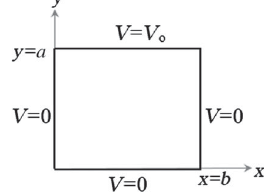
FIG. 3. The multiple-response CUE question related to the Cartesian SOV. The prompt has been shortened and paraphrased; see Ref. [13] for full